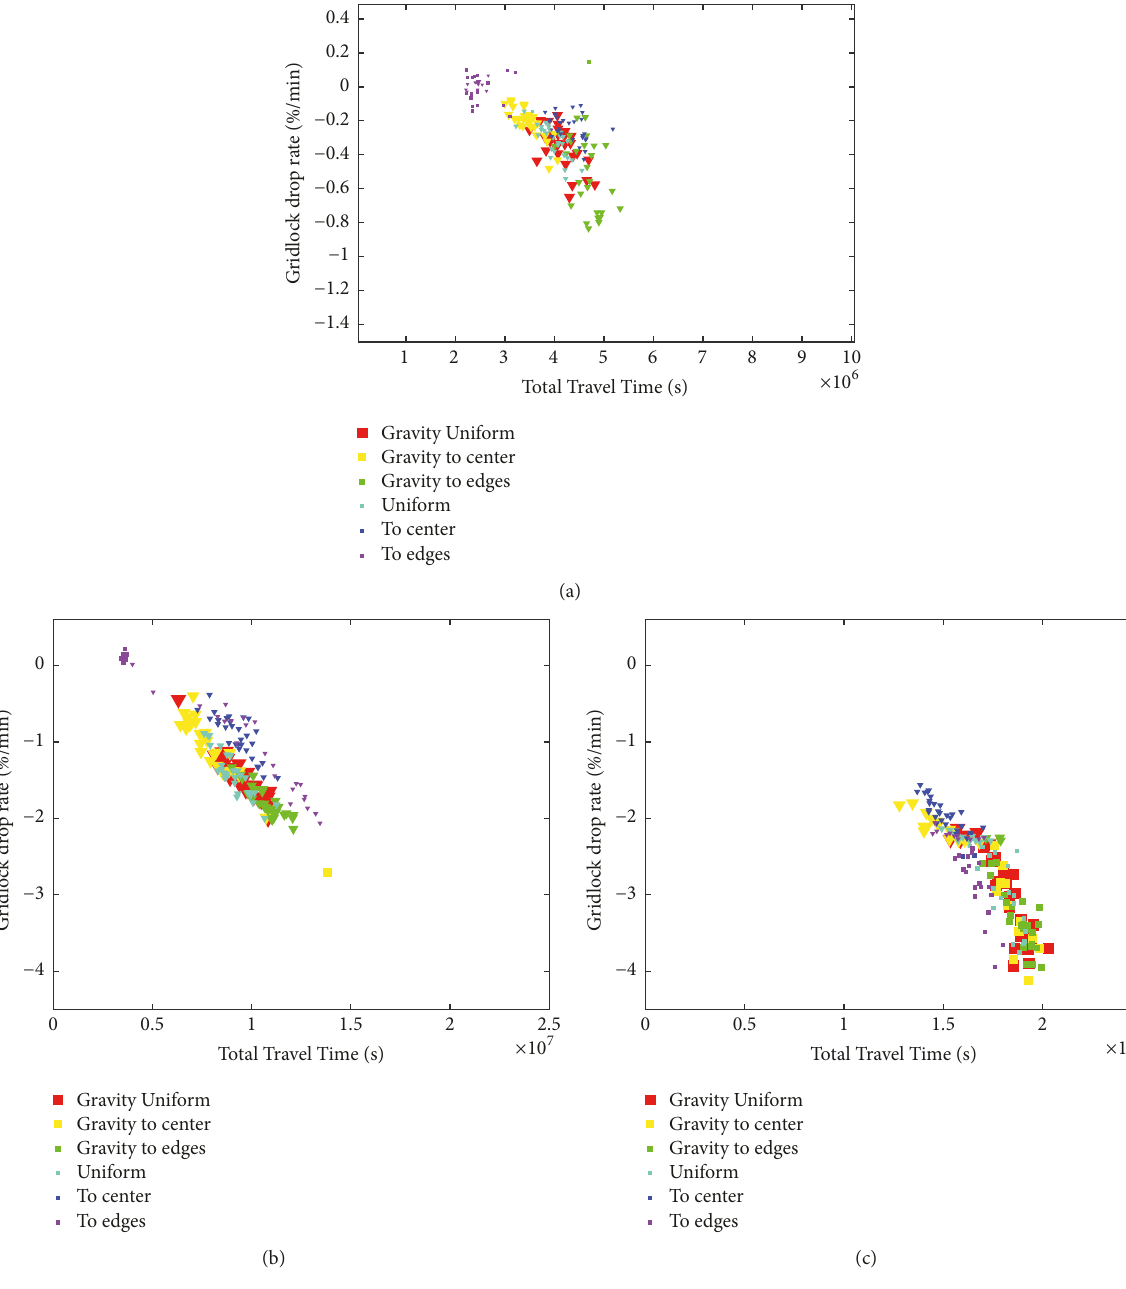
Figure 11: Gridlock drop rate: 1h30 simulations with dynamic assignment. (a) Demand level 4, (b) demand level 5, and (c) demand level 6.